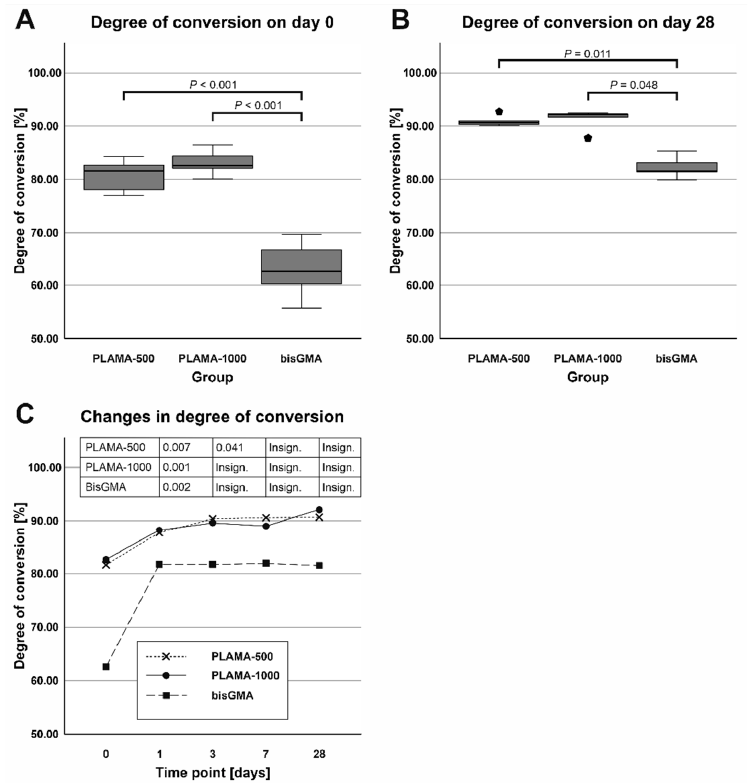
Figure 4. Comparison of the average degree of convergence (DC) in all groups measured on day 0 curve resembling that of elastomers (Figure 5B), which was in line with subjective obser-